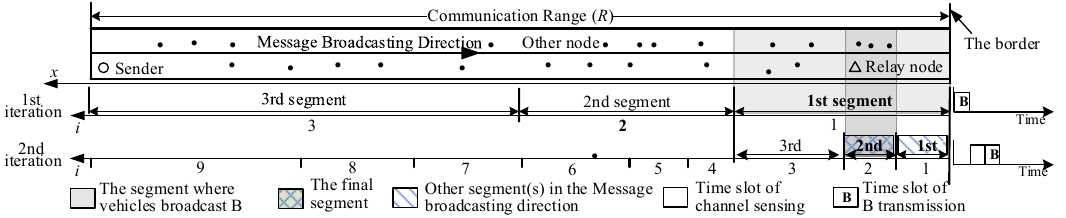
Figure 1. Example of the exponent-based partition, ( N iter , N part ) = ( 2,3 ) .